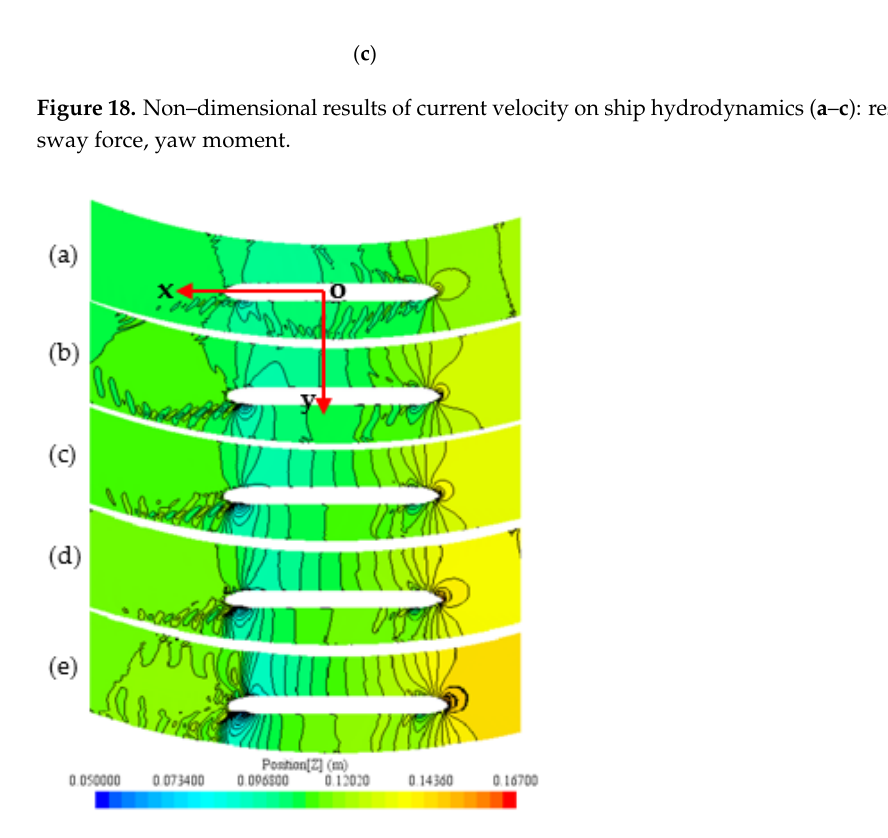
Figure 20. Pressure contours with streamlines of current velocity. ( a – e ): current velocity = 0 m/s, 0.1 m/s, 0.15 m/s, 0.2 m/s, 0.25 m/s. 5. Conclusions In this paper, numerical simulations based on implicit unsteady equations and the realizable K-Epsilon turbulence model were performed to investigate the curvature effect of curved channels on ship hydrodynamics. A verification study via grid convergence analysis according to ITTC in a curved channel was performed to select the most appro- priate grid setting, and also validation research in a straight channel validated by experi- ment results was conducted to prove that the numerical model estimates hydrodynamic